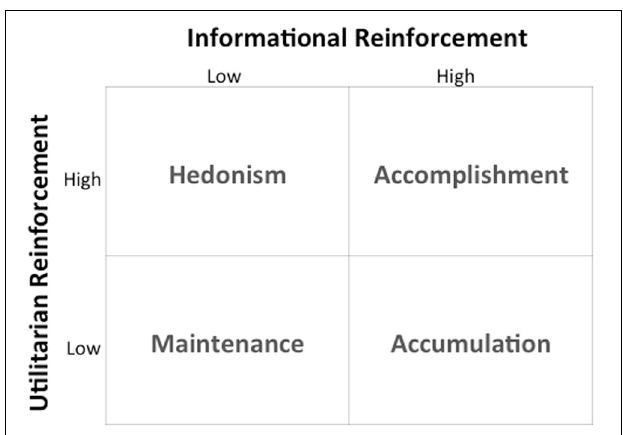
FIGURE 2 | Pattern of reinforcement and operant classes of consumer behavior. Adapted from Foxall (1990/2004). Used by